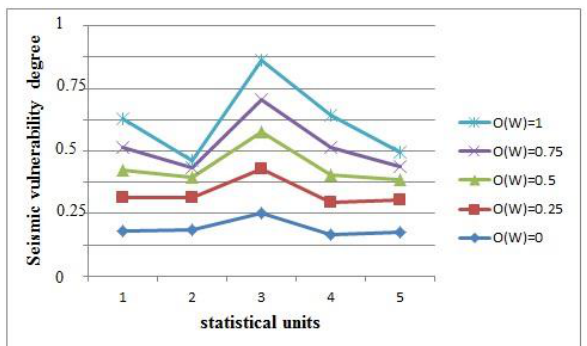
The order weights in minimal variability OWA is derived using